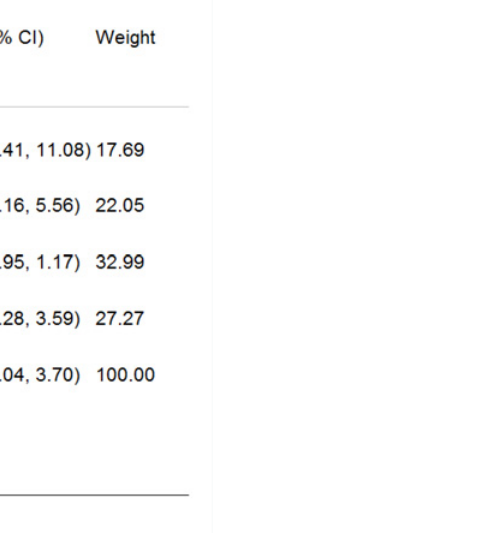
PLOS ONE | DOI:10.1371/journal.pone.0150532 March 15,